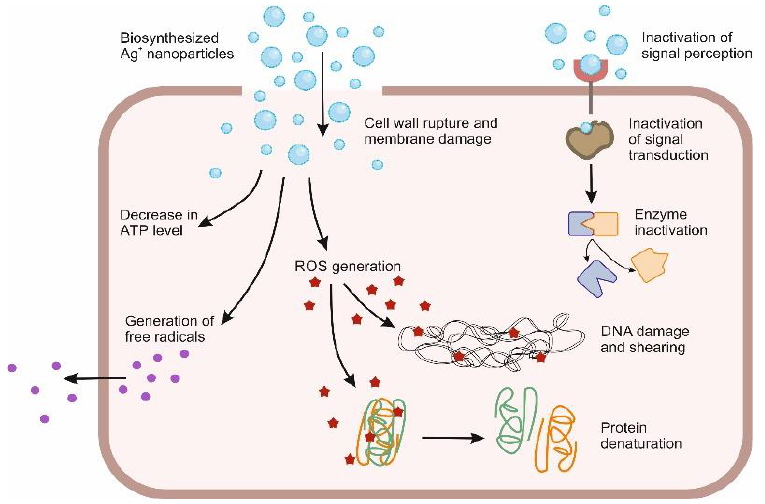
Figure 3. Biofunctionalized AgNPs as topical bullet for enhanced delivery and promising technology for wound healing.